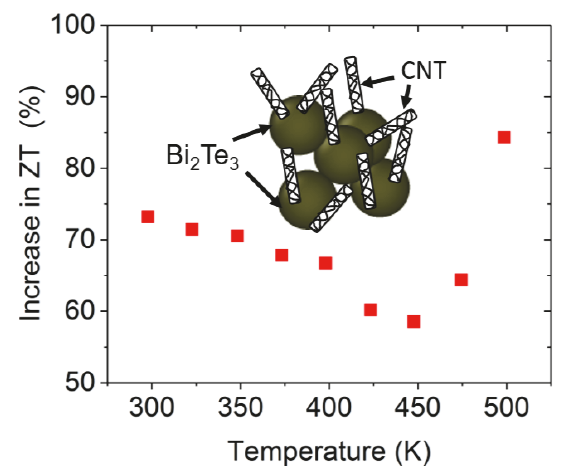
Figure 16: Increase in the ZT of Bi 2 Te 3 by creating MWCNT-Bi 2 Te 3 composite [173]. The inset shows the schematic of the